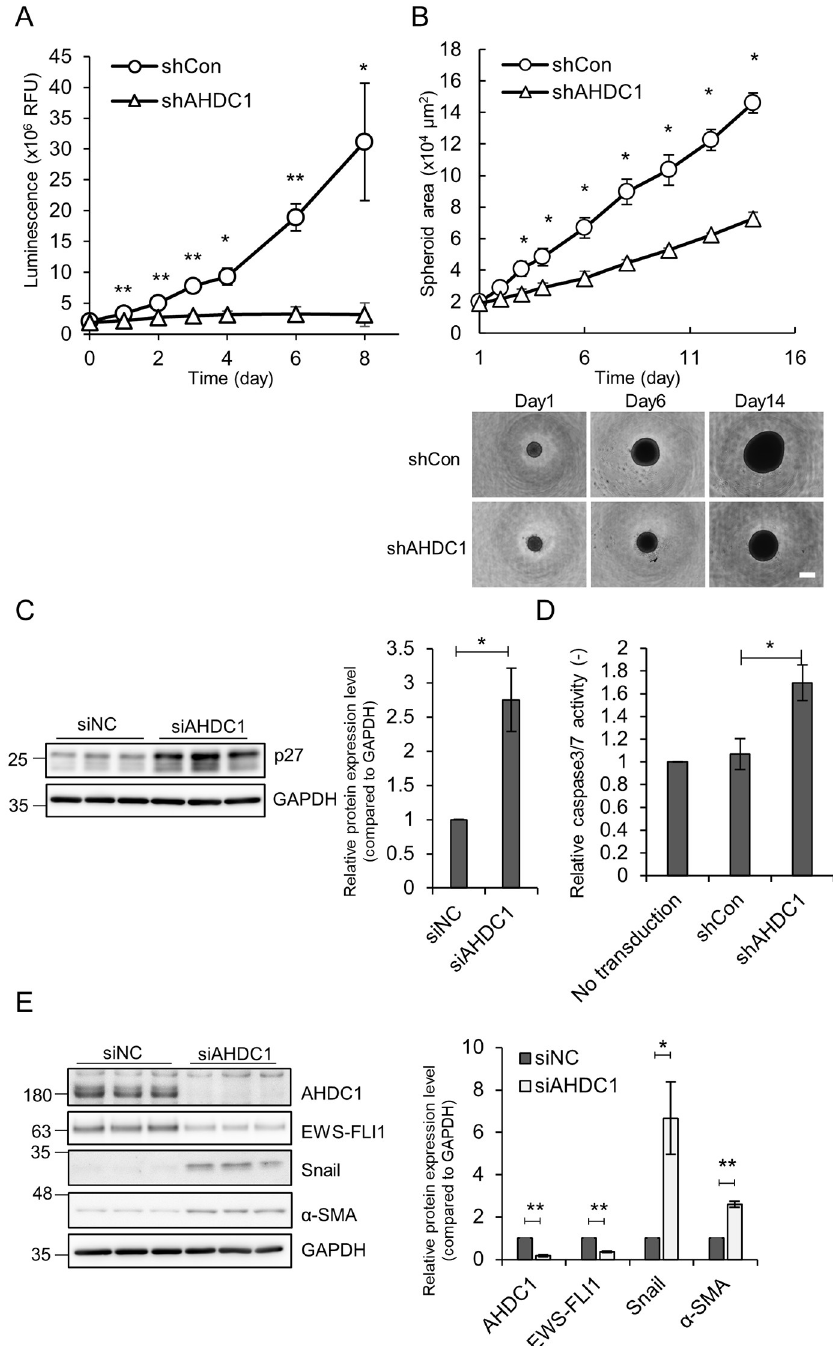
Fig 4. AHDC1 knockdown reduces cell growth in Ewing’s sarcoma cells. (A) Lentivirus expressing shRNA was transduced to A673 cells for 3 d. 1 × 10 3 Cells were spread onto a 96-well plate and cultured again. Cell viability was determined by CellTiter-Glo2.0 on the indicated day. (B) shRNA-expressing cells were transferred into a 3D culture plate. The spheroid size was determined by a Keyence BZ-810X microscopy. Scale bar, 500 μ m. (C) siAHDC1-treated A673 cells were cultured for 2 d. Western blotting analysis was performed by p27 and GAPDH antibodies. Relative values were normalized by GAPDH. (D) Lentivirus expressing shRNA was transduced to A673 cells for 3 d. Caspase activity was measured by a Caspase-Glo 3/7 Assay. (E) siAHDC1-treated cells were analyzed by western blotting. P values were calculated by the student’s t-test. � p < 0.05; �� p < 0.001.